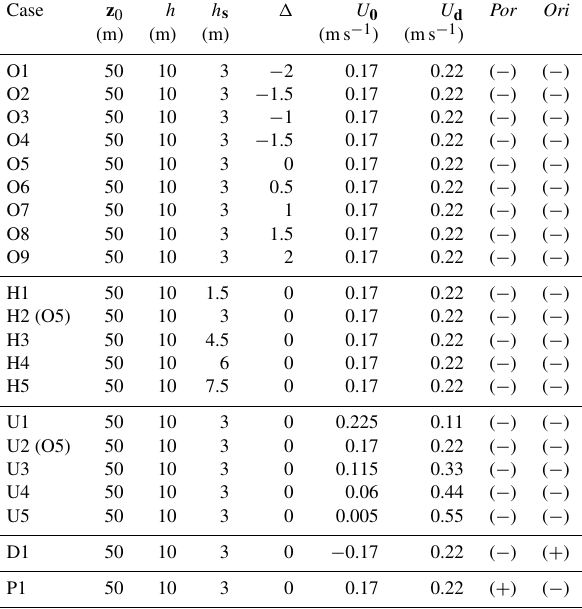
Table 1. Summary of parameters of variable background shear cur- rents. The depth and thickness of the pycnocline are denoted by z 0 and h . The thickness of the shear layer is denoted by h s , and the offset cases are indicated by asymmetry parameter (cid:49) . The mag- nitude of the shear current is denoted by U d , and U 0 is the mean background velocity of the water column. Por indicates the polarity of the background shear current, and “ + ” means a polarity-reversal shear current. The orientation of the background shear current is indicated by Ori , and “ + ” means an opposing shear